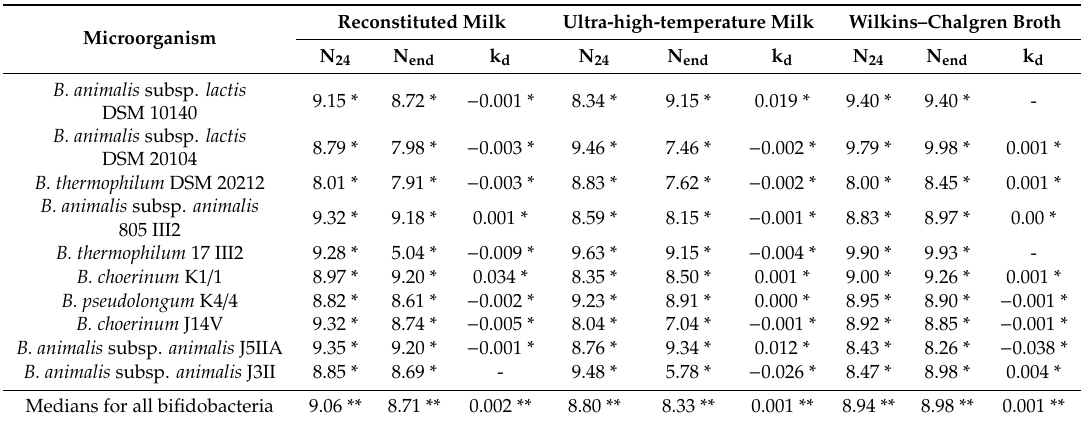
Table 2. Parameters evaluating behavior of Bifidobacterium spp. during 28 days of cold storage (6 ± 1 ◦